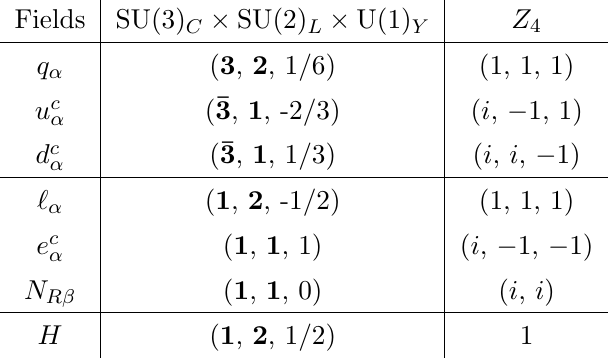
Table 1 . Charge assignments for the SM (cid:12)elds and the right-handed (cid:12)eld N R , common to all the models. Not all the (cid:12)elds are charged under the extra global U(1) X symmetry. We consider the standard number of generations (cid:11) = 1 ; 2 ; 3, while (cid:12) = 1 ; 2, to give masses to two active light neutrinos, which is the minimal phenomenologically viable choice. In the last column in the brackets we indicate Z 4 charges for the three